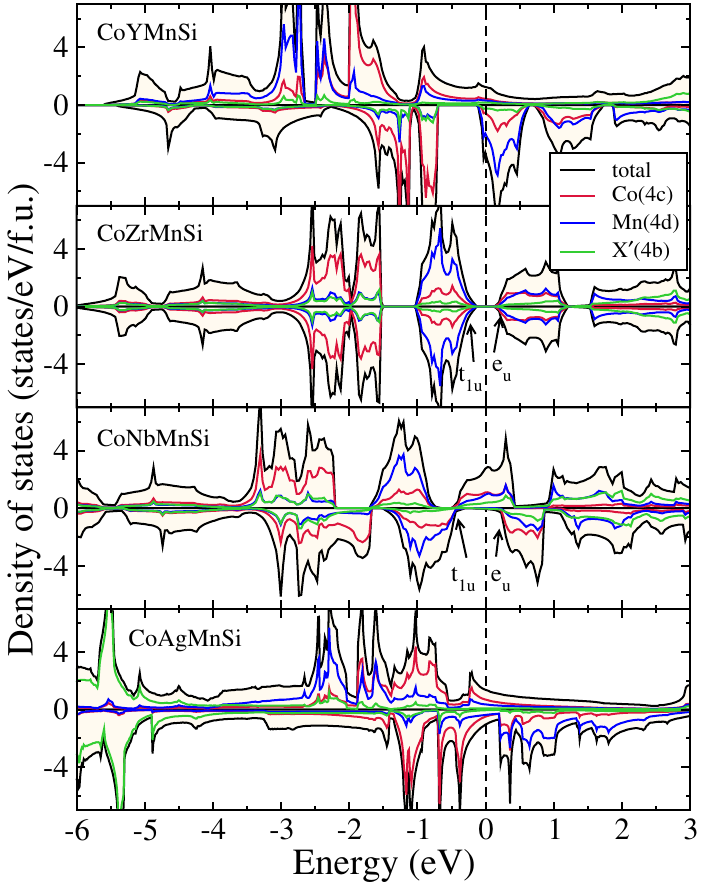
Figure 4. Spin polarized total and atom-projected densities of states for CoX ′ MnSi (X ′ = Y, Zr, Nb, Ag) alloys. The ground states of these compounds are